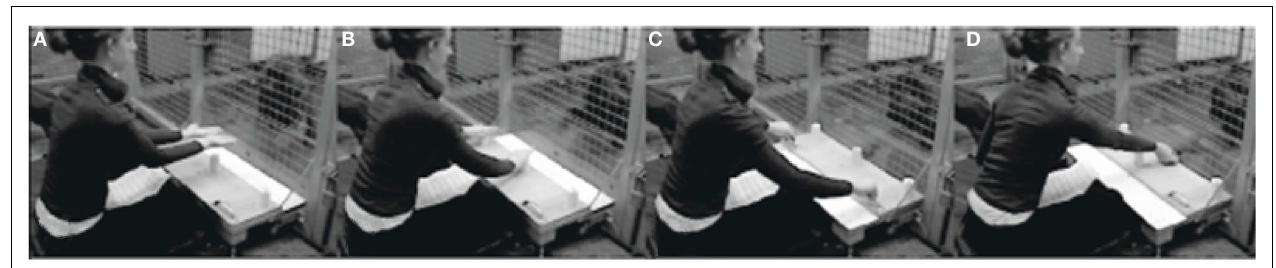
showed a subject a quantity of reward in her hand(s) (simultaneous condition shown). (B) The reward(s) were placed into opaque cylinders. (C) The panel was pushed forward and the subject indicated his choice by pointing to a cylinder. (D) The subject received the reward he